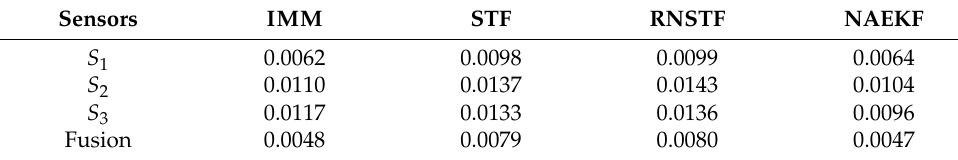
Table 11. Estimation errors of the azimuth angle ( ◦ ).